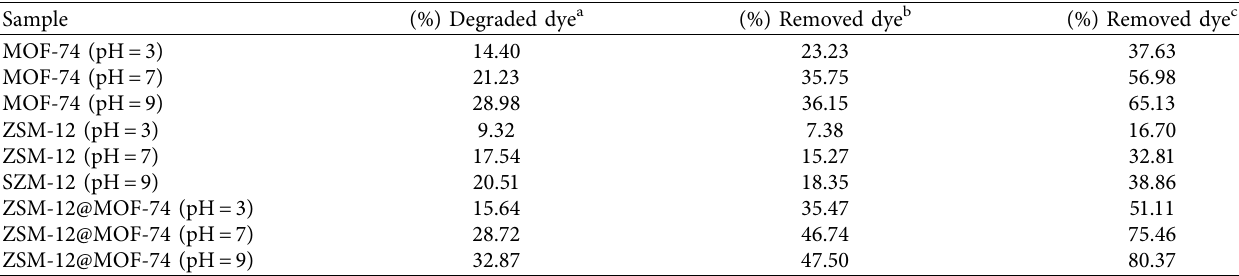
Figure 33: Proposed photo-catalytic degradation of ZSM-12@MOF-74 core@shell adopted from [33]. Table 3: Te photo-catalytic performances of the MOF-74(Zn) and ZSM-12@MOF-74 at MB � 10ppm, the photo-catalyst dosage: 0.4g/L, at 30min dark and 30 min under visible light irradiation